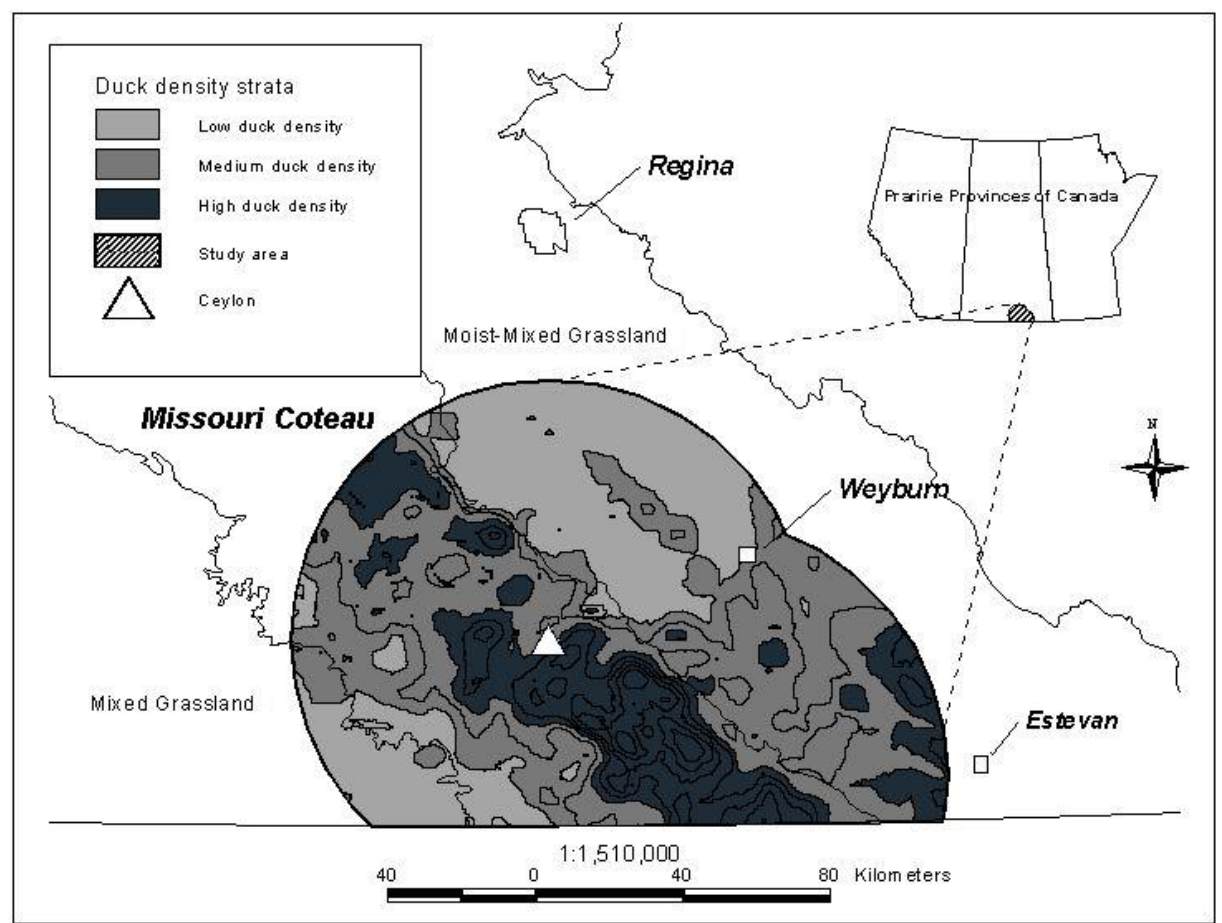
Fig. 1. Location of the study area, overlapping the southeastern portion of the Missouri Coteau in southern Saskatchewan, Canada. Duck density: low, < 8 pairs/km²; medium, 8–15 pairs/km²; high, > 15